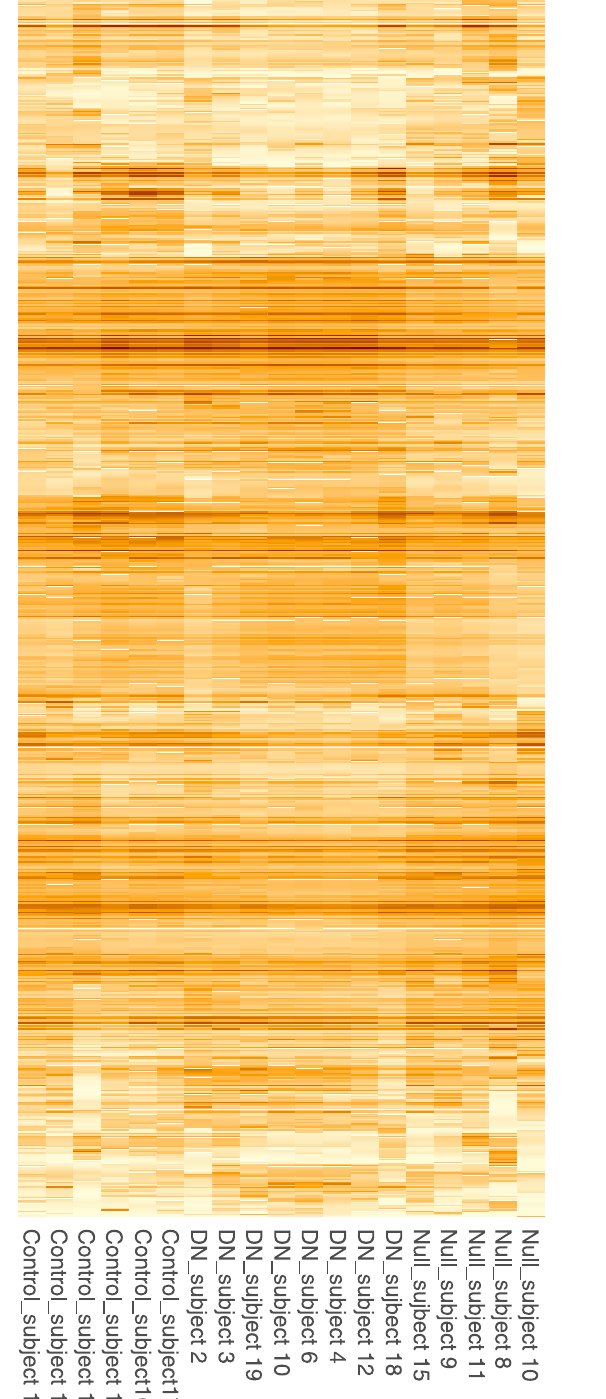
Fig 1. Heatmapof FPKM expression values for 1246 differentially expressedgenes in cultured fibroblasts from COL6-RD subjects and controls. Heatmap generatedusing the csHeatmap function in cummeRbund[11]and includinga non-overlappinglist of DE genesin DN vs control, Null vs control, and DN vs Null comparisons.